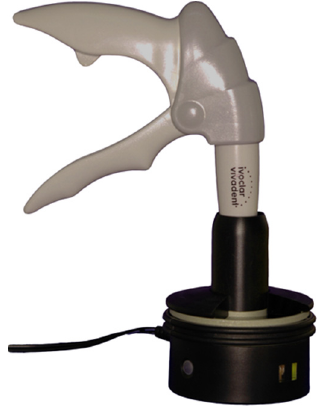
Figure 1. Calset applicator.